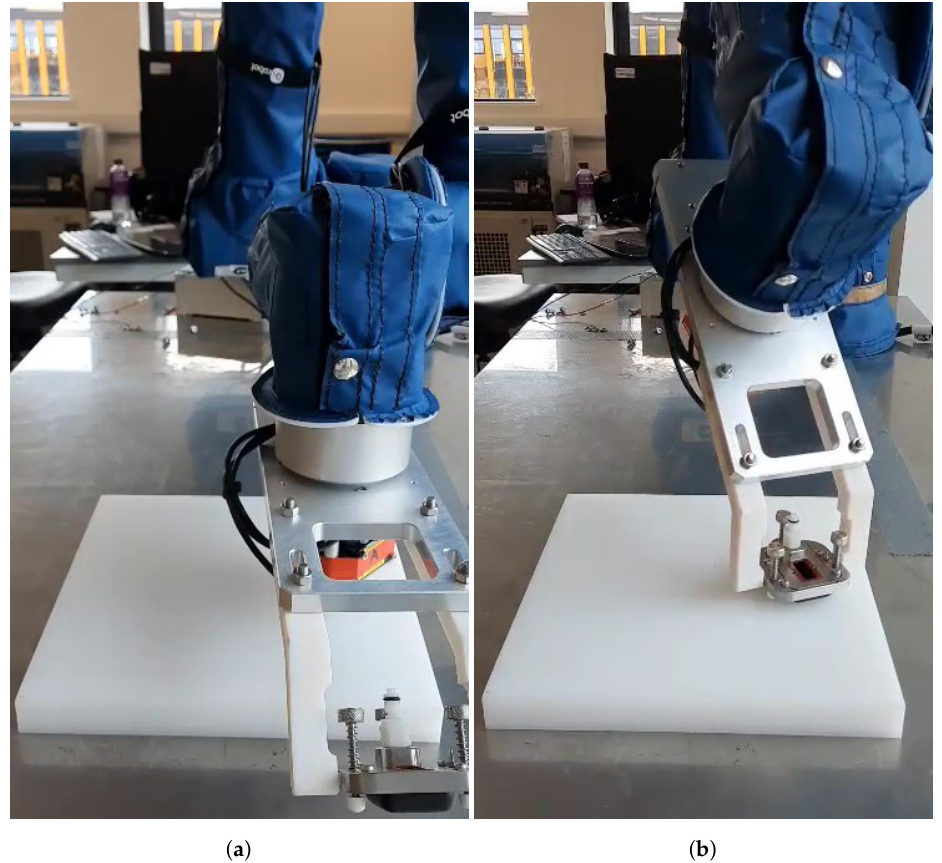
Figure 14. Automatic online single-pass profiling of a surface. ( a ) Initial non-contact surface discovery and profiling with the tri-laser. ( b ) Subsequent application of the Conformable-Wedge coupled UT